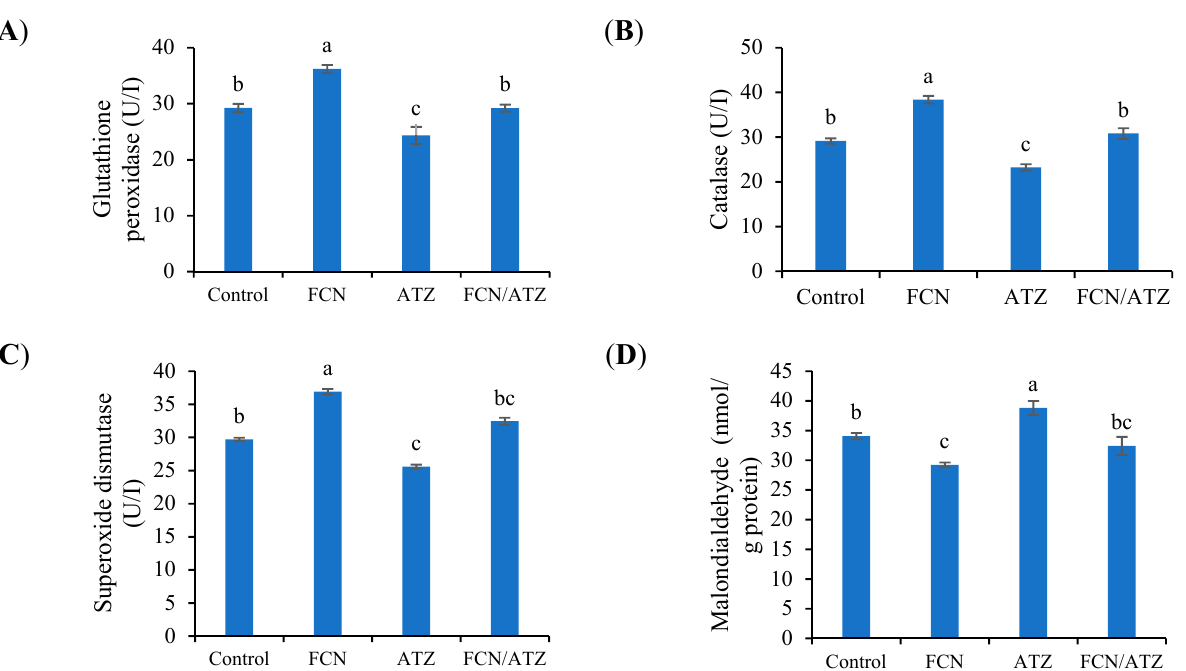
Figure 5. The blood antioxidative traits of Nile tilapia fed fucoidan and exposed to atrazine. Bars present means ± S.E. with